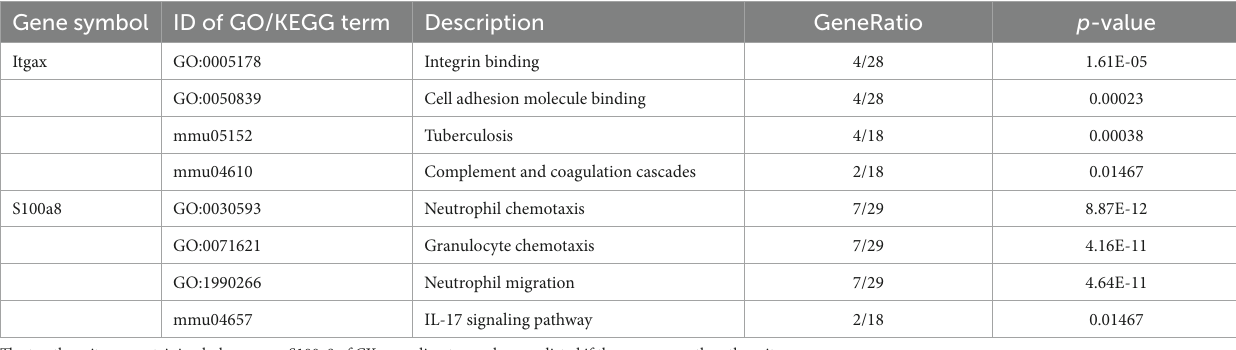
TABLE 3 GO and KEGG items.